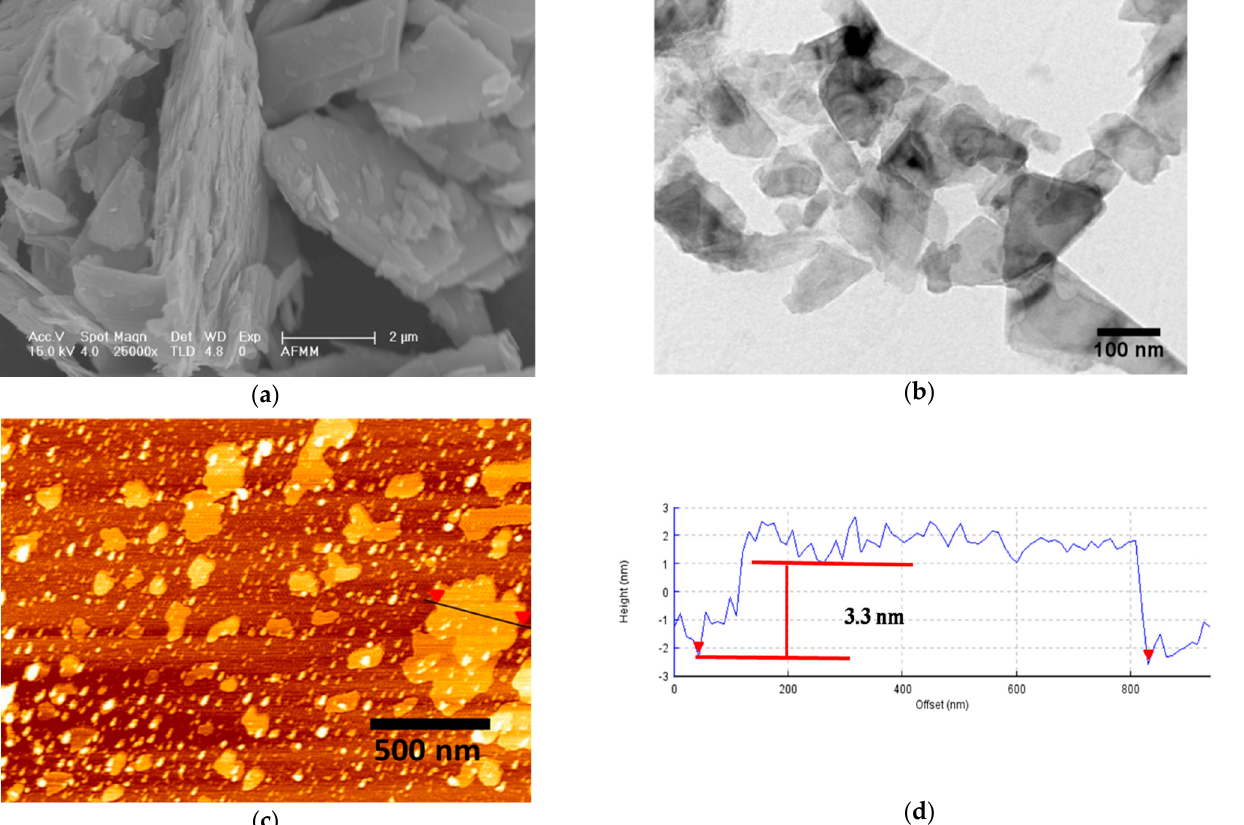
Figure 2. ( a ) SEM micrograph of bulk MoS 2 platelets, ( b ) TEM image of exfoliated f-MoS 2 nanoplatelets. ( c ) AFM image of the exfoliated f-MoS 2 nanoplatelets. ( d ) Height profile of the exfoliated f-MoS 2 nanoplatelets.